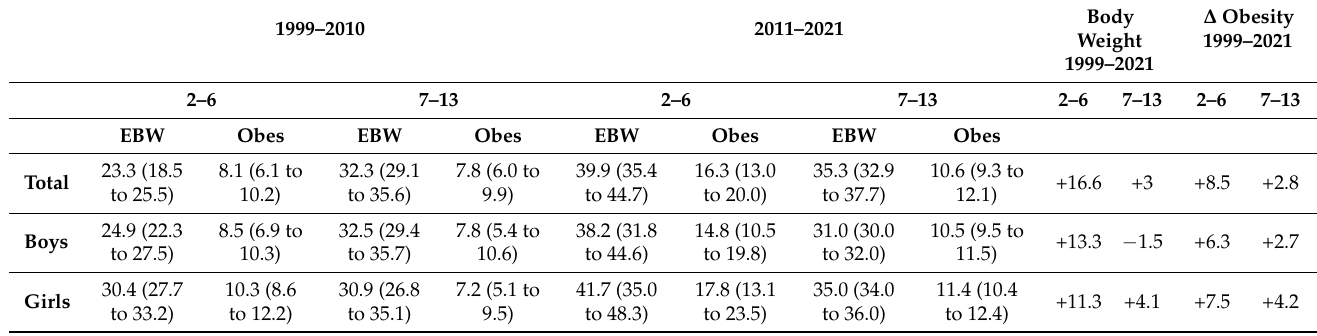
Table 2. Trends in the prevalence (pool estimate (95% confidence interval) of excess body weight (overweight plus obesity) and obesity in Spanish children aged 2–6 years and 7–13 years, using IOTF definition